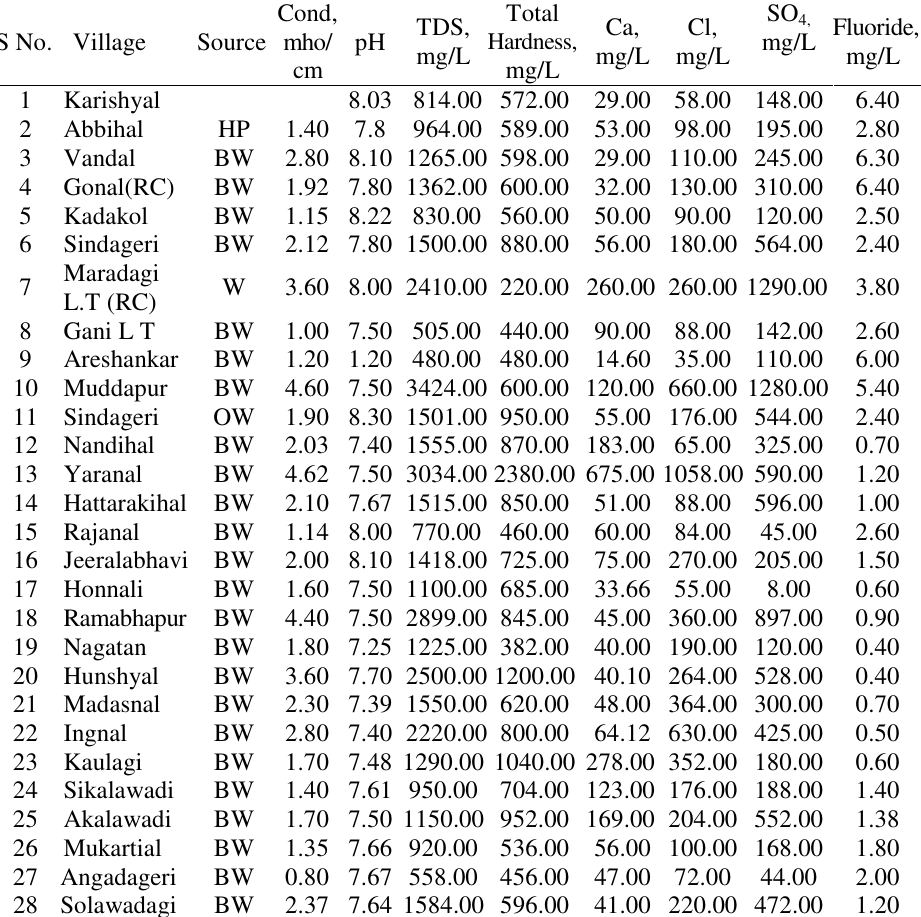
Table1. Physicochemical characteristics of water quality in selected villages of Basavan- Bagewadi